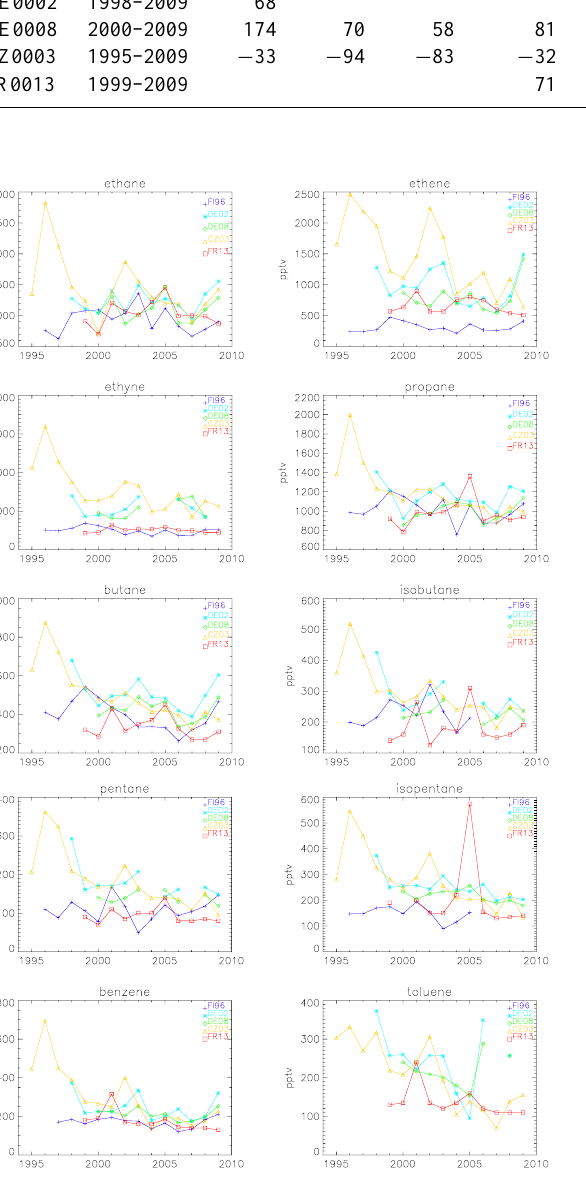
Fig. 18. Annual winter (January, February, November, December) median concentrations of hydrocarbons at Pallas (FI96),